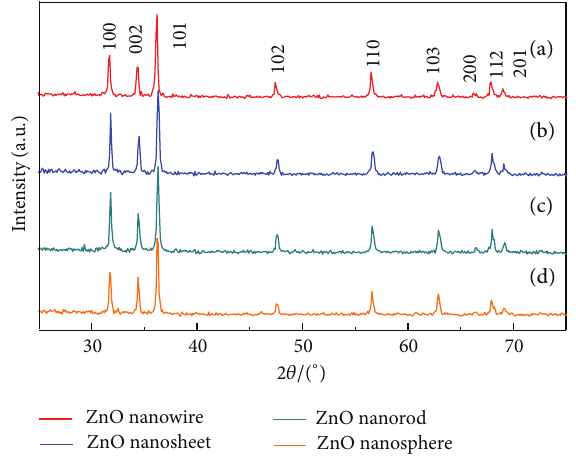
Figure 3: XRD diffraction patterns of the prepared ZnO nanostruc-